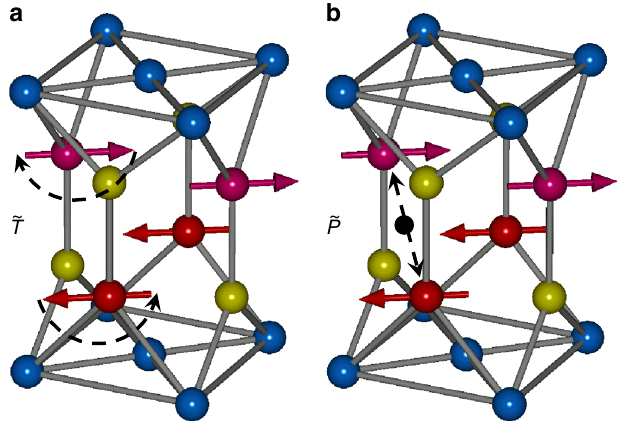
Fig. 6 Time reversal and space inversion operation in the CuMnAs magnetic lattice. a The time reversal operation ~ T fl ips the magnetic moments, highlighting the broken time reversal symmetry. b Black point shows the inversion center of the space inversion symmetric non-magnetic lattice. However, the space inversion operation ~ P that exchanges magnetic atoms around the black point does not leave the antiferromagnetic lattice invariant, i.e., space inversion symmetry is broken in antiferromagnetic CuMnAs. The combined ~ P ~ T operation remains a symmetry even in the antiferromagnetic